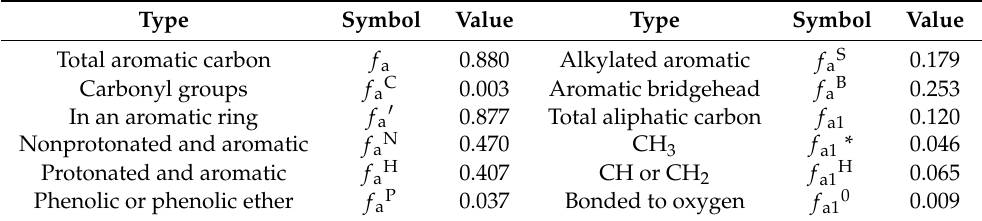
Table 4. Structure parameters of gas